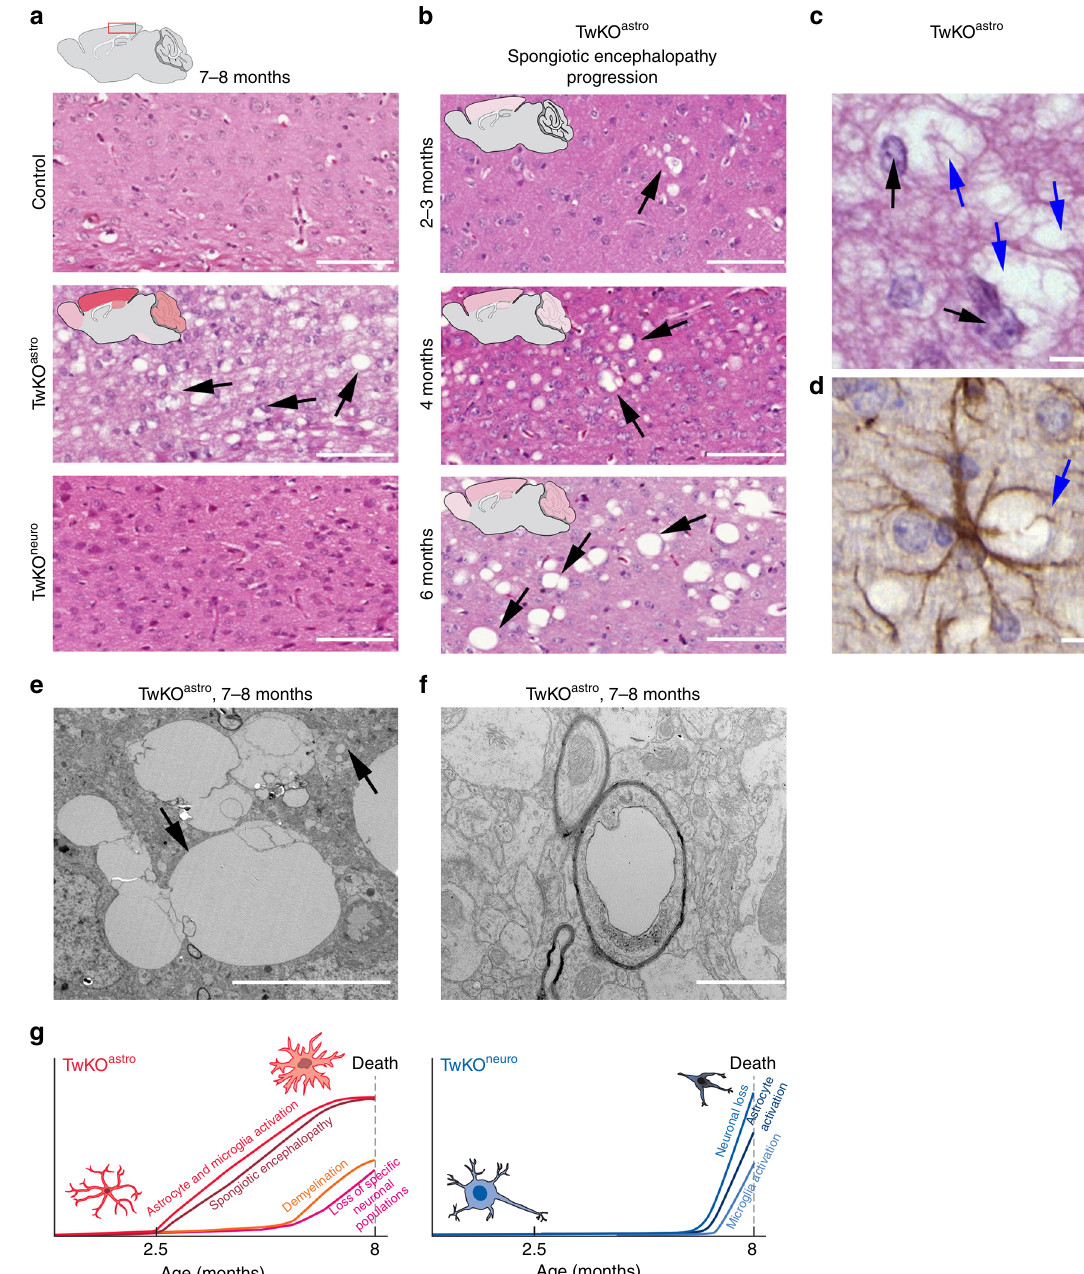
Fig. 8 Inactivation of Twinkle in astrocytes leads to brain vacuolization and spongiotic encephalopathy. a Cortical morphology with hematoxylin/eosin staining from terminal stage of TwKO astro and TwKO neuro mice. Representative images of the brain mid-sagittal sections. Extensive brain vacuolization in TwKO astro indicated with arrows. b Spongiotic encephalopathy of TwKO astro has progressive nature. Brain graphs show the affected regions with severity of pathology demonstrated with intensity of the color shading. c Vacuoles (blue arrows) and astrocyte nuclei (black arrows) in hematoxylin/eosin staining. d Immunohistochemistry of GFAP in TwKO astro and vacuoles enwrapped by an astrocyte (blue arrow). e Representative electron micrograph of vacuoles. Upper arrow indicates a vacuolated mitochondrion, lower arrow indicates group of vacuoles in the brain of TwKO astro . f Representative electron micrograph of vacuolated myelinated axon. Brain graph shows sampling site. Scale bars: 100 μ m ( a , b ); 10 μ m ( c ), 5 μ m ( d ). g Time-course development of brain pathology in TwKO astro and TwKO neuro NAD + , NADH, NADP + , and NADPH measurement . Pyridine nucleotide con- centrations in tissues were measured using cycling assay similar to previous publication 43 .